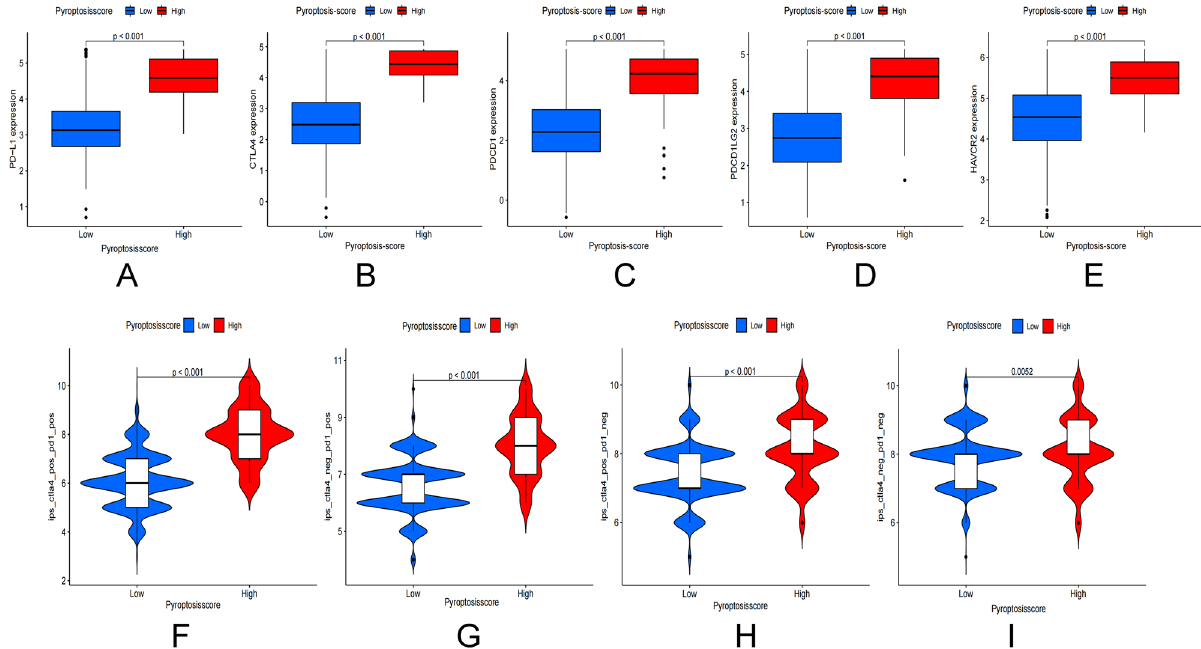
Figure 5. Correlation between pyroptosis score and immune blocking sites. ( A–E ) Correlation analysis between PD-L1, CTLA4, PDCD1, PDCD1LG2, HAVCR2 expression and pyroptosis score. ( F–I ) Correlation between IPS immunotherapy and pyroptosis